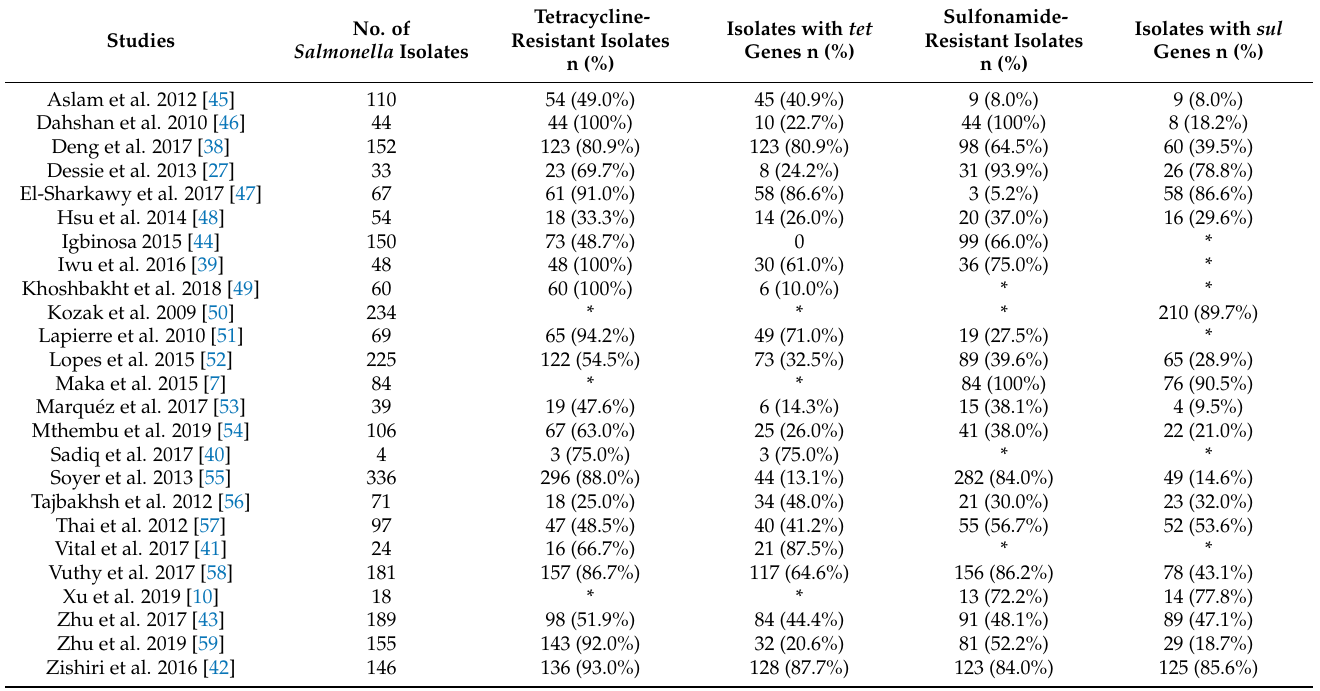
Table 2. Prevalence of tetracycline and sulfonamide resistance in relation to the total number of Salmonella isolates. Tetracycline- Isolates with tet No. of Resistant Isolates Studies Salmonella Isolates Genes n